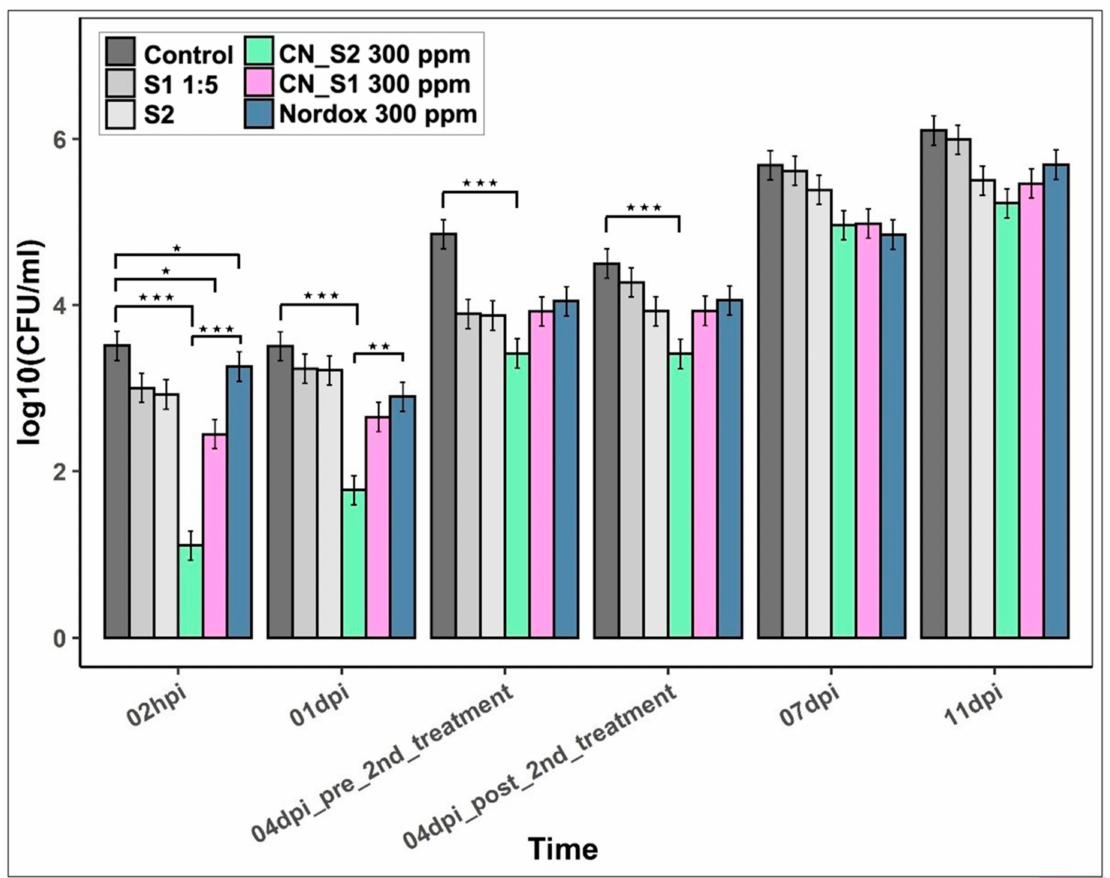
Figure 2. X. campestris pv. vesicatoria population growth in tomato leaves sprayed with the two copper nanoparticles (CN_S2 and CN_S1), their stabilizers S2 and S1 and Nordox at concentration of 300 ppm. Estimated means and corresponding standard errors of the logarithm of the bacterial population from 4 samples are shown. *: p < 0.05; **: p < 0.01; ***: p < 0.001 according to Tukey post hoc